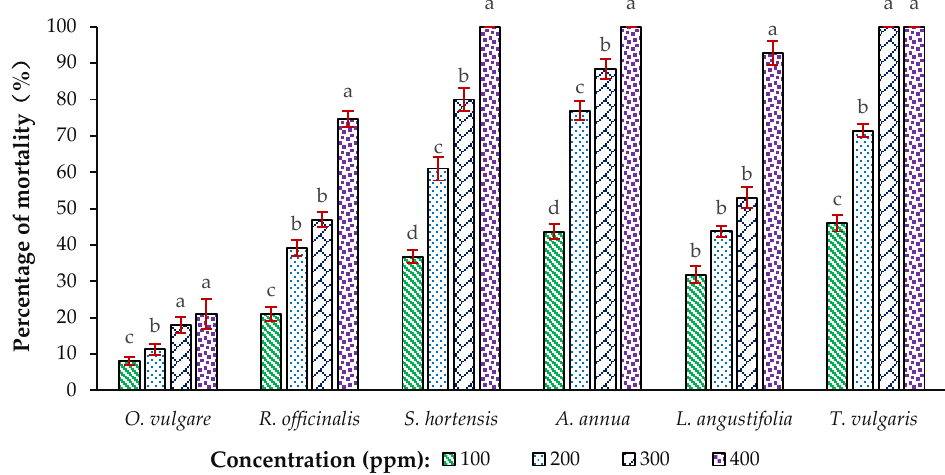
Figure 1. Ovicidal activity of applied essential oils against Xanthogaleruca luteola eggs. Statistical differences are shown by different letters according to Tukey’s test at p ≤